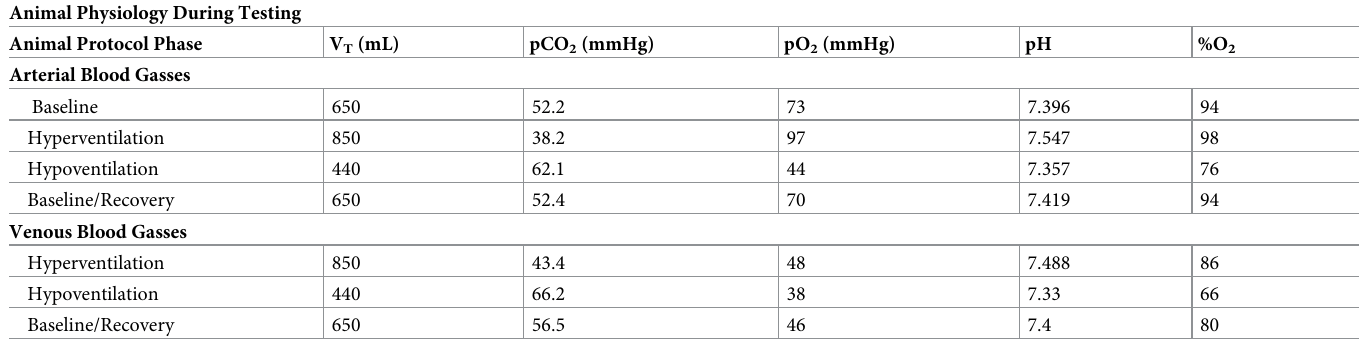
Table 3. Measurement of blood gasses of the animal subject during the phases of the ventilation treatment. Animal Physiology During Testing Animal Protocol Phase